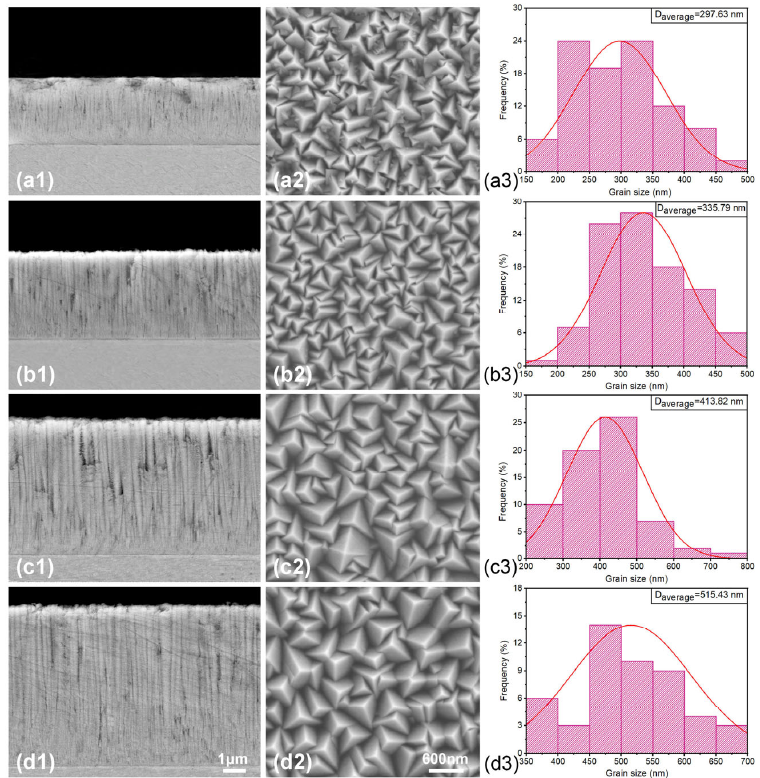
Figure 4. SEM micrographs and grain size diagrams of Cr coatings under different powers: ( a1 – 3 ) 100 W; ( b1 – 3 ) 150 W; ( c1 – 3 ) 200 W; ( d1 – 3 ) 250 W.